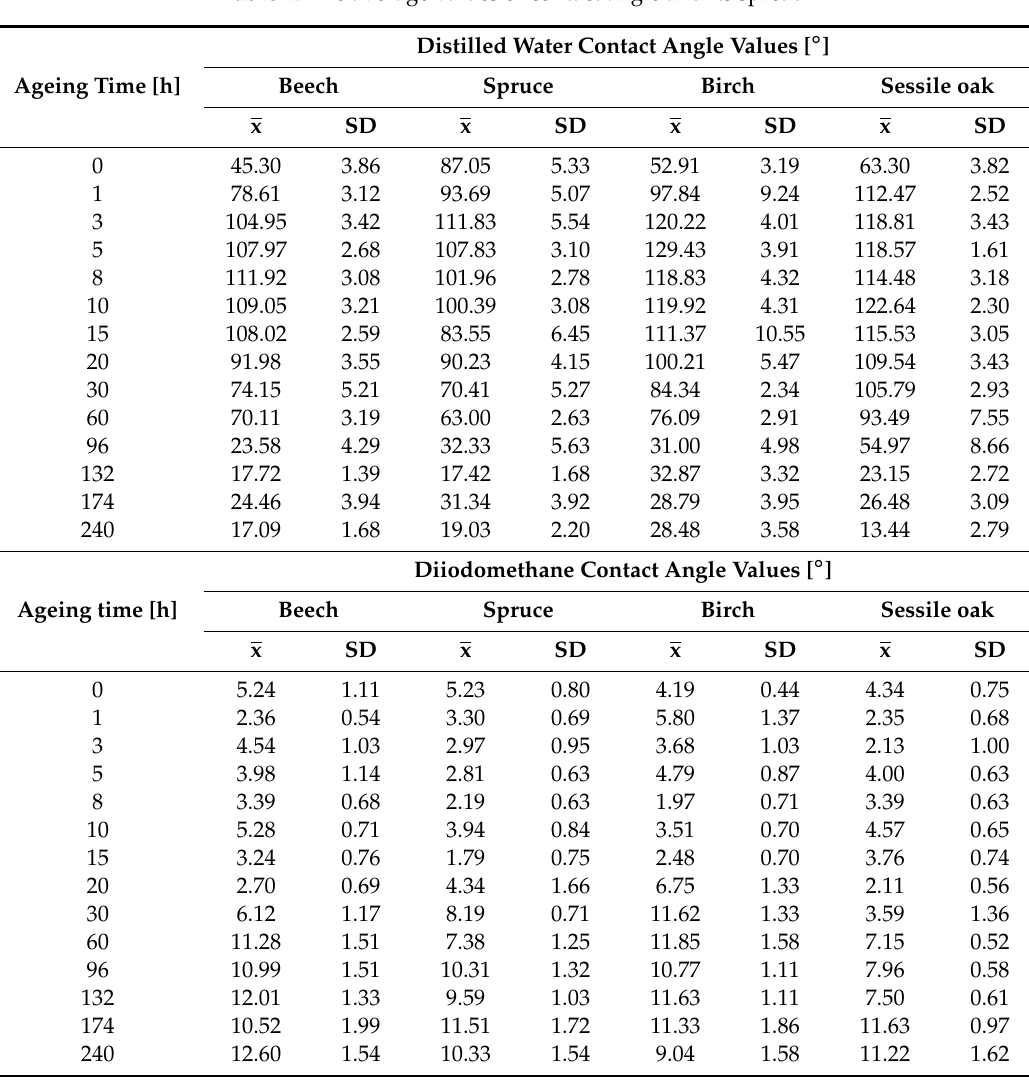
Table 2. The average values of contact angle and its